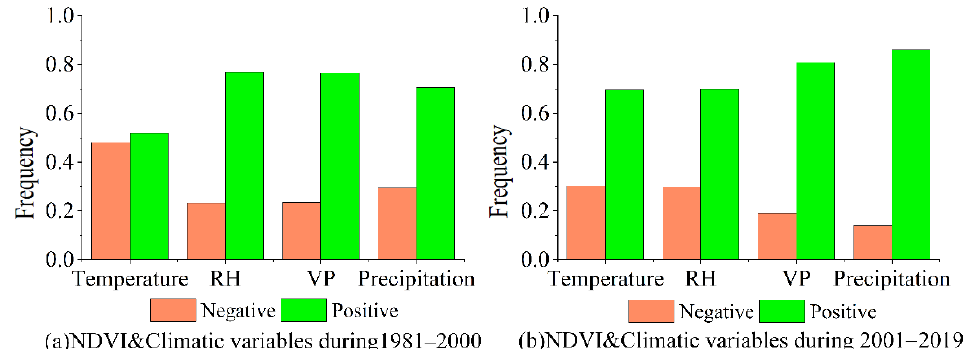
Figure 7. The frequency of correlations between NDVI max and the four climatic variables (RH is relative humidity; VP is vapor pressure).